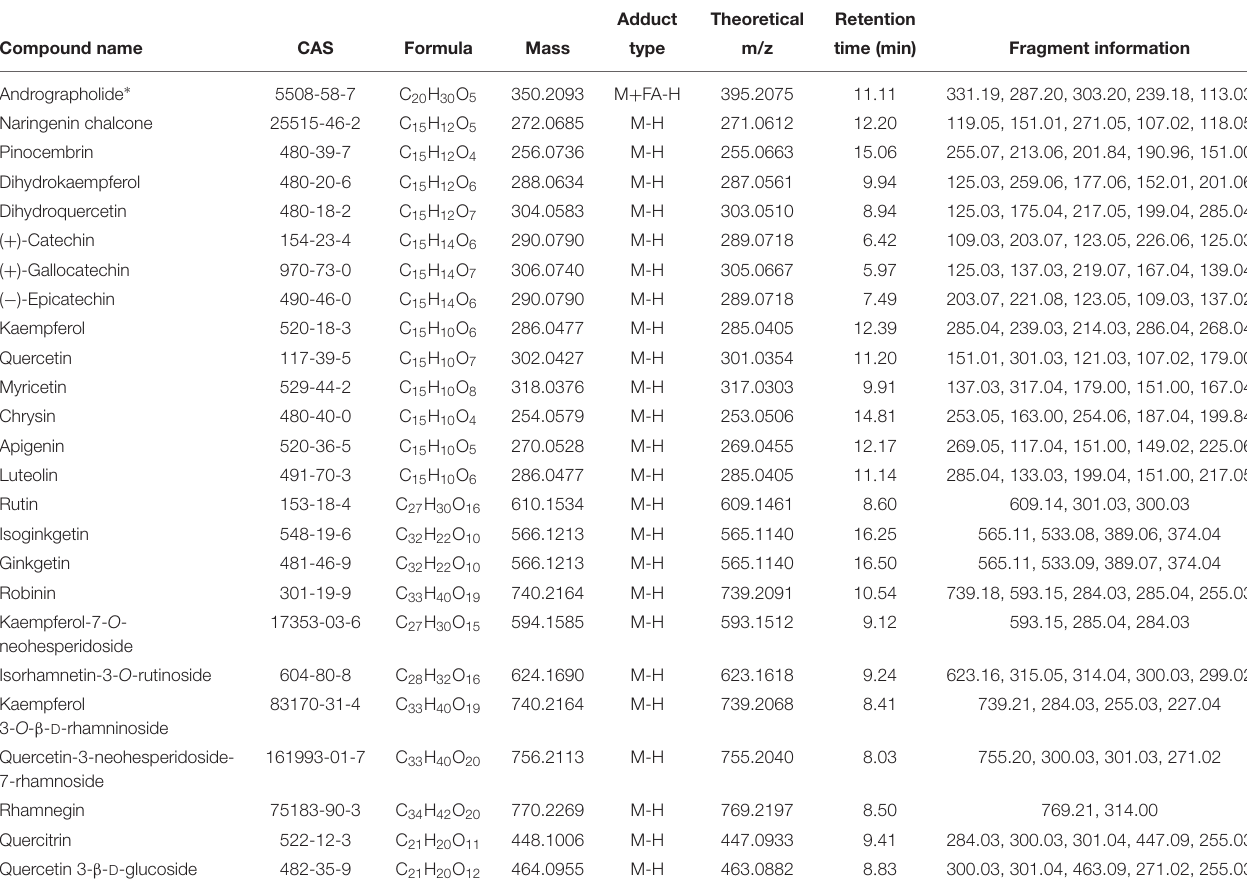
TABLE 1 | LC–MS identification results of metabolites related to flavonoid biosynthesis and flavonoid